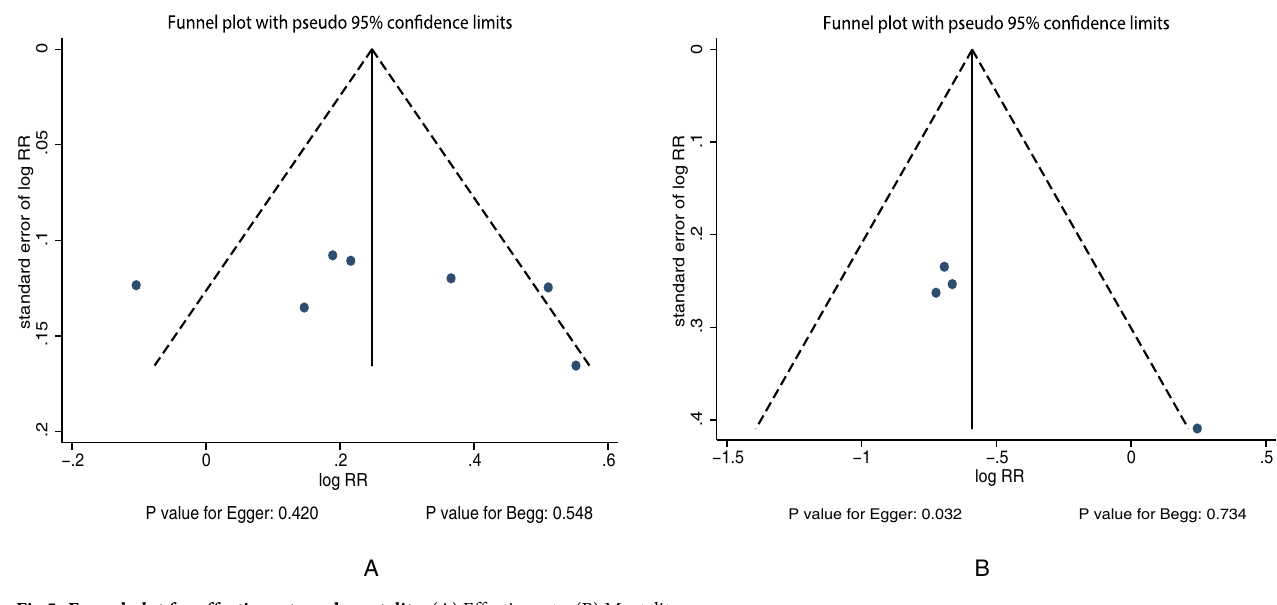
Fig 5. Funnel plot for effective rate and mortality. (A) Effective rate. (B)